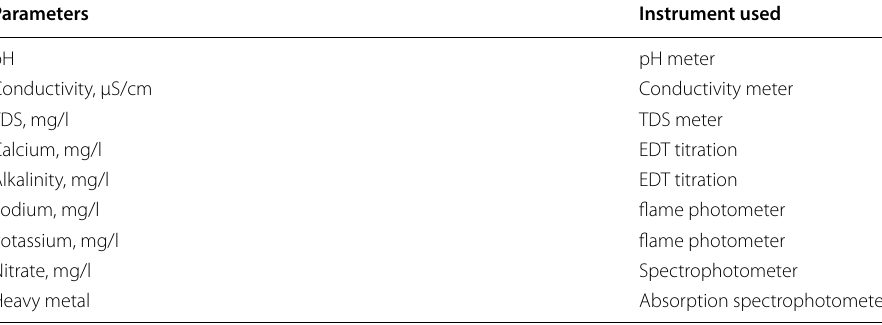
Table 2 The methods of analysis of different parameters of leachate